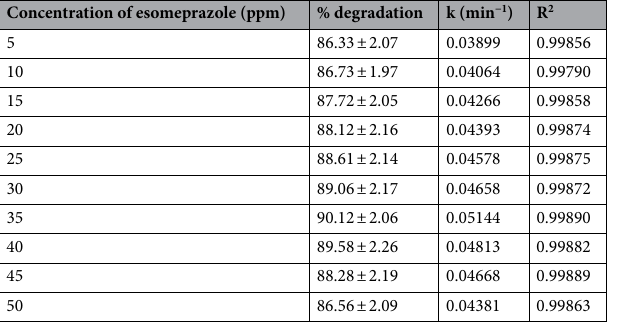
Concentration of esomeprazole (ppm)